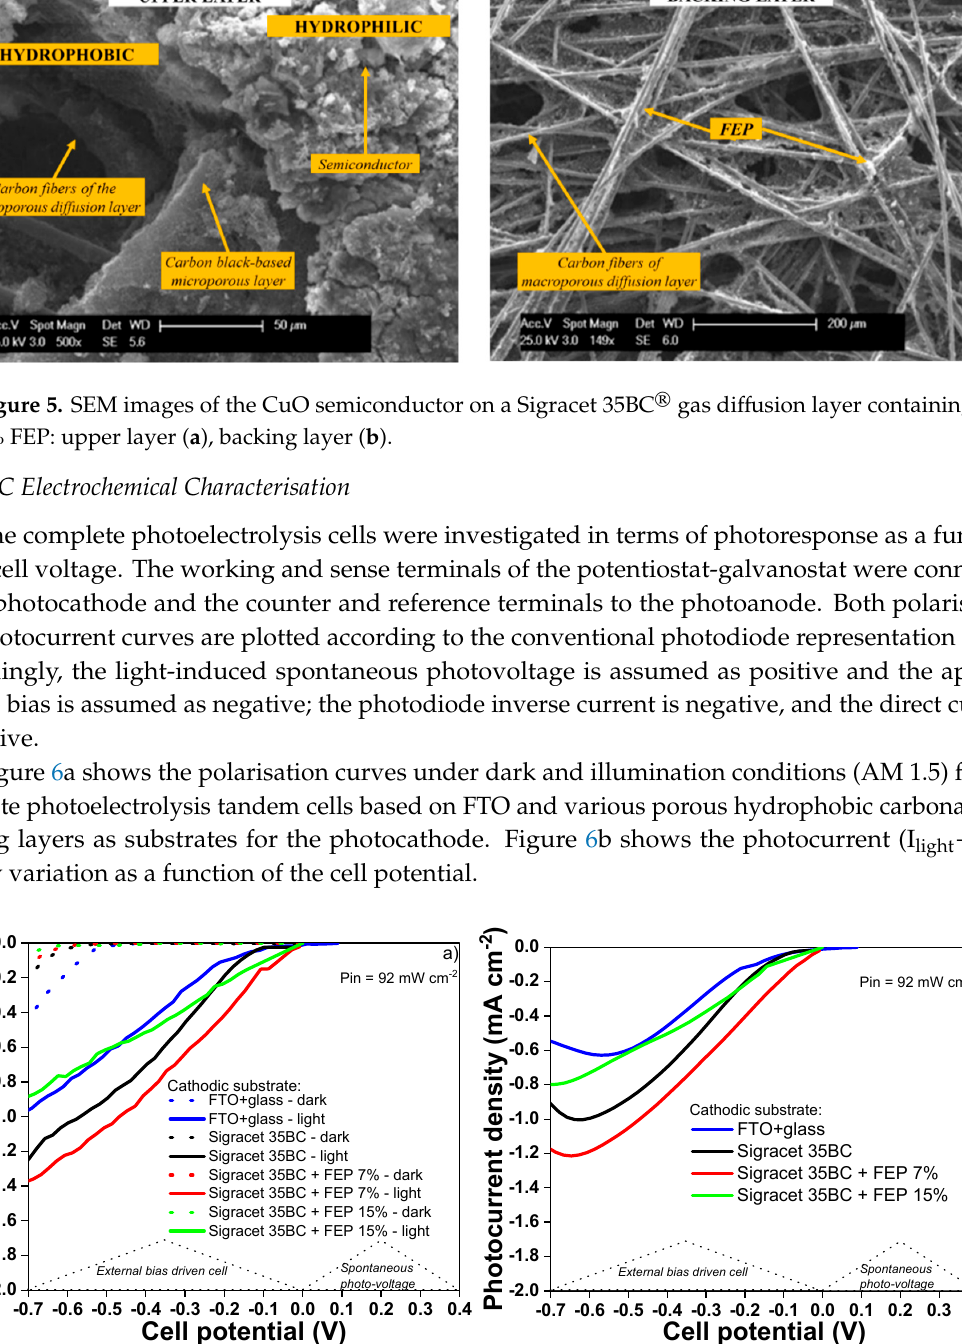
Figure 6. Polarisation curves of the PEC cell (glass + FTO + Fe 2 O 3 + NiFeO X + ionomer/FAA-3/ionomer + CuO + cathodic substrate), for various cathodic substrates, between − 0.7 and 0.4 V ( a ), photocurrent density vs cell potential between − 0.7 and 0.4 V ( b ); in the photodiode representation mode an applied bias corresponds to a negative cell potential.